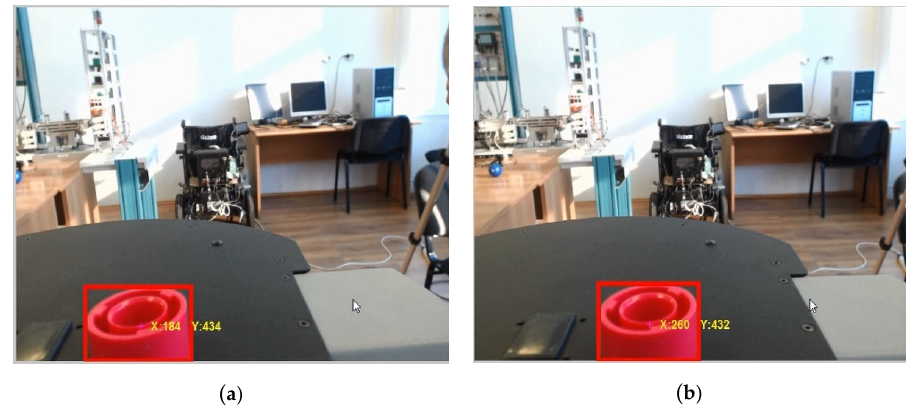
Figure 24. Real-time control of RM Cyton for retrieving the work-piece from ARS PeopleBot based on eye in hand VSS for precise positioning: ( a ) (X:184, Y:434); ( b ) (X:260, Y:434).